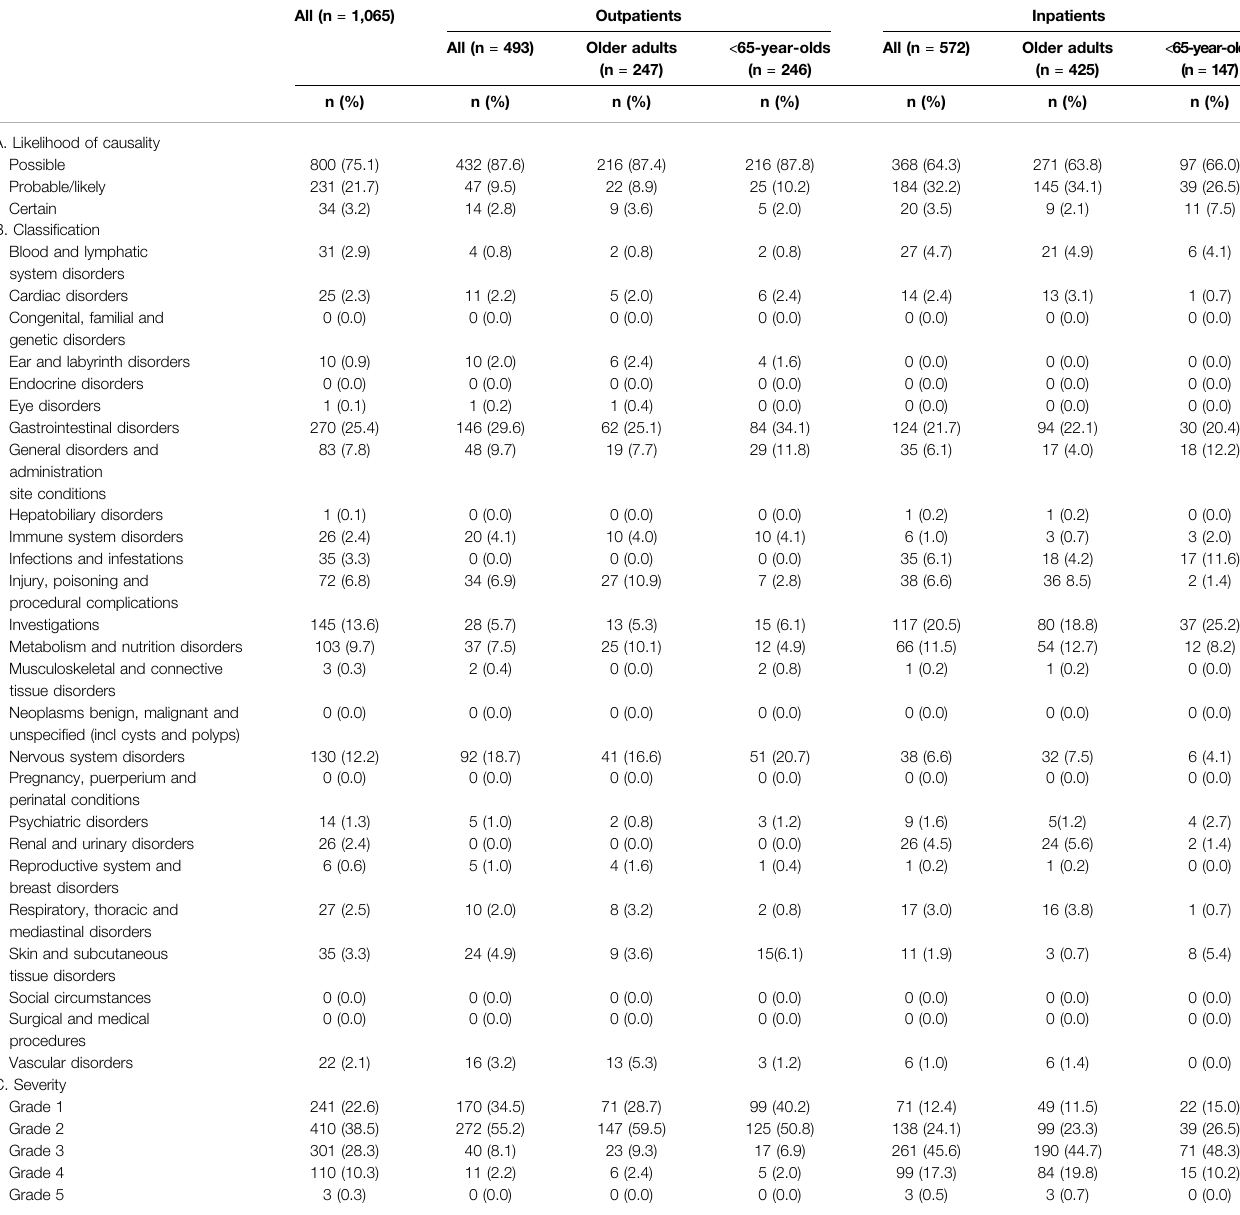
TABLE 4 | Adverse drug